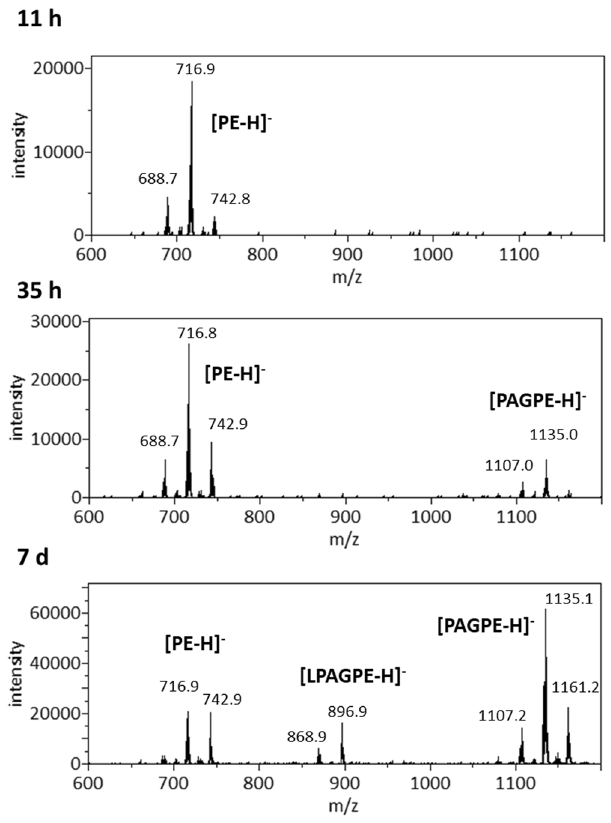
Figure 3. Precursor scans for m/z 140 anionic head group fragment. The most abundant peaks of phosphatidylethanolamine (PE), 1-phosphatidyl-2-acyl-glycero-3-phosphoethanolamine (PAGPE) and lyso-1- phosphatidyl-2-acyl-glycero-3-phosphoethanolamine (LPAGPE) anions are labeled. Top: Cells were grown for 11 h after inoculation. Middle: Cells were grown for 35 h. Bottom: Cells were grown for